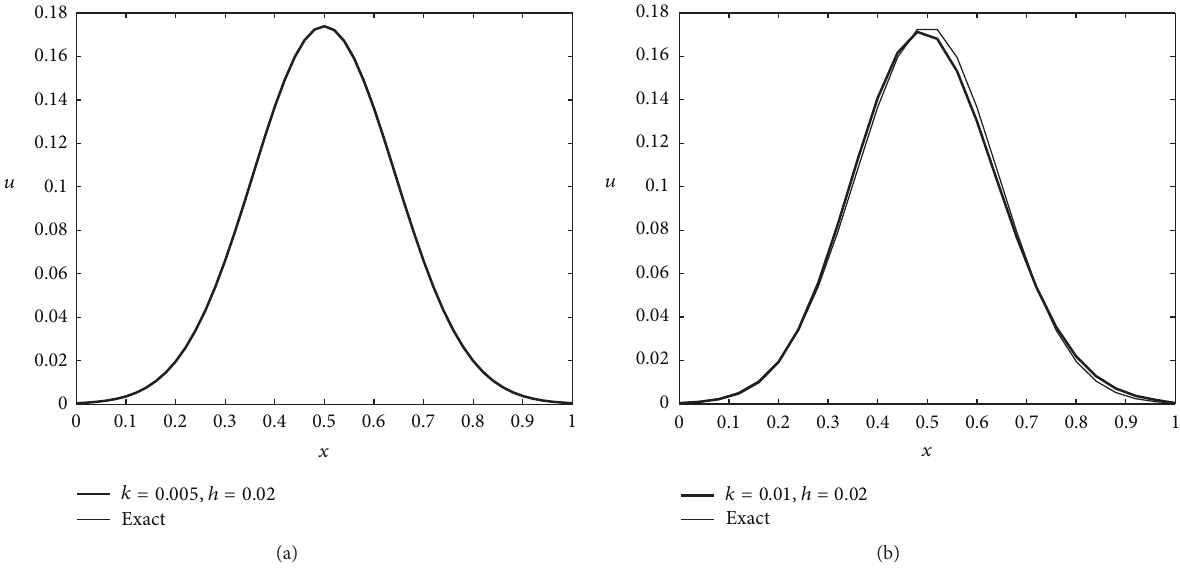
Figure 2: Comparison of numerical results with exact results using Lax-Wendroff scheme at some values of 𝑘 and ℎ . The region of stability is 0 < 𝑠 ≤ (1 − 𝑐 2 )/2 [14]. Plots